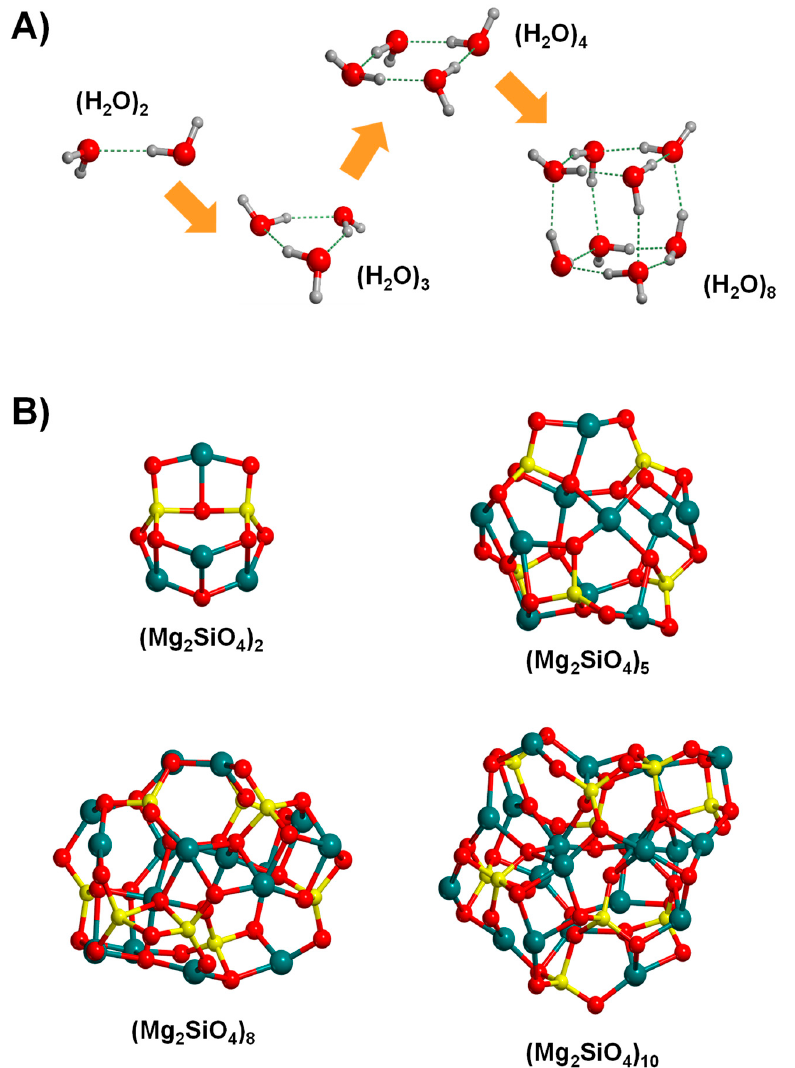
Figure 6. Cluster systems generated by the bottom-up approach: for water clusters by increasing the size adopting a water-by-water addition ( A ) and for silicate clusters by using the Monte Carlo basin hoping global optimization algorithm ( B ).